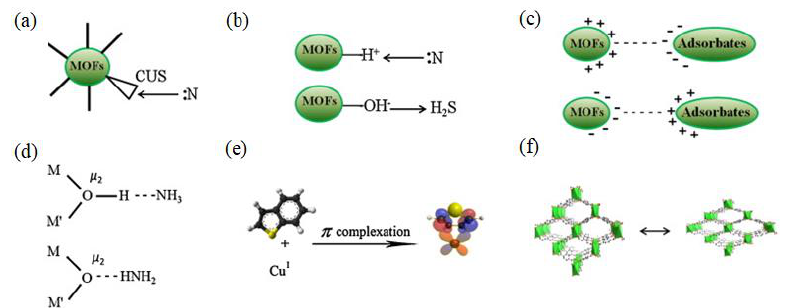
Figure 8. Main mechanisms between NOx and active sites of MOFs. Modified from [171] with permission from Elesvier, Copyright 2013. ( a ) Adsorption on coordinatively unsaturated sites (CUS); ( b ) Acid base interaction; ( c ) Electrostatic interaction; ( d ) Hydrogen bonding; ( e ) п- complex formation; ( f ) Breathing effect.